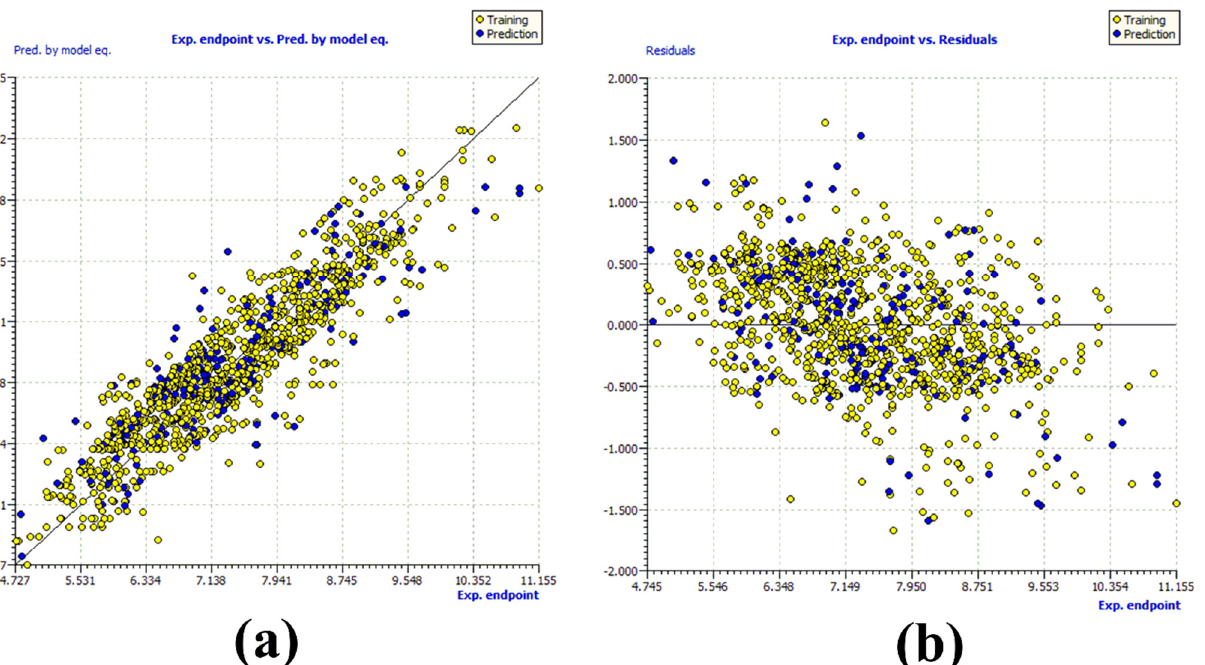
Figure 3. Graph for ( a ) experimental vs. predicted pKi (the solid line represents the regression line); ( b ) experimental vs. residuals; ( c ) Williams plot for applicability domain (the vertical solid line represents h* = 0.023 and horizontal dashed lines represent the upper and lower boundaries for applicability domain); ( d ) Y-randomization. 3. Discussion 3.1. Mechanistic Interpretation of QSAR Model A properly validated correlation between salient features of the molecules, repre- sented by molecular descriptors, and their bioactivity expands information about mecha- nistic aspects of molecules, specificity and quantity (presence and even absence) of vari- ous structural traits for the desired bioactivity. In the present analysis we have compared the Ki values of different molecules in correlation and as an effect of a specific molecular